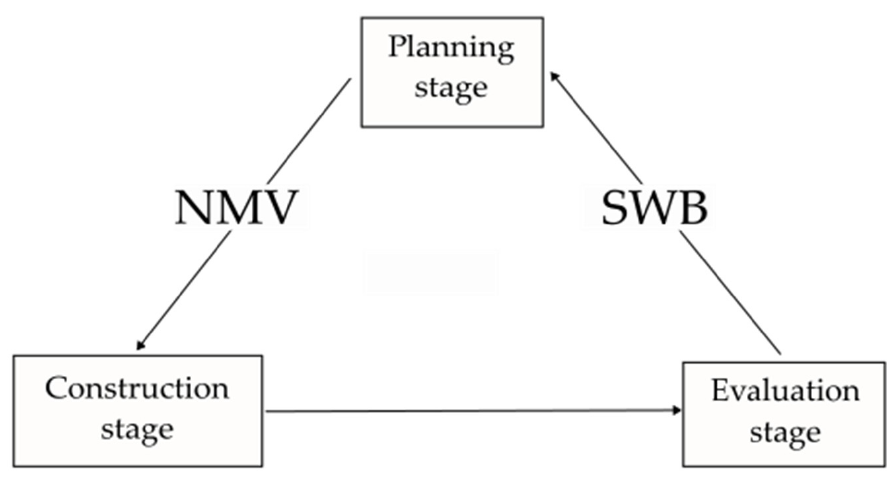
Figure 10. The relevance of the two methodological approaches within a project’s life cycle.